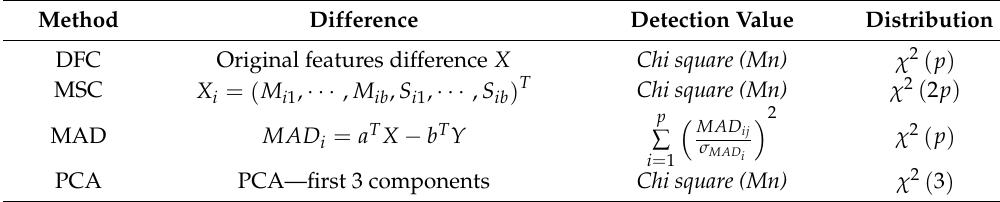
Abbreviations used in this table: DFC: Direct Feature differentiation based chi-square transformation; MSC: Mean and Standard deviation signature based chi-square transformation; MAD: Multivariate Alteration Detection; PCA: Principal Component